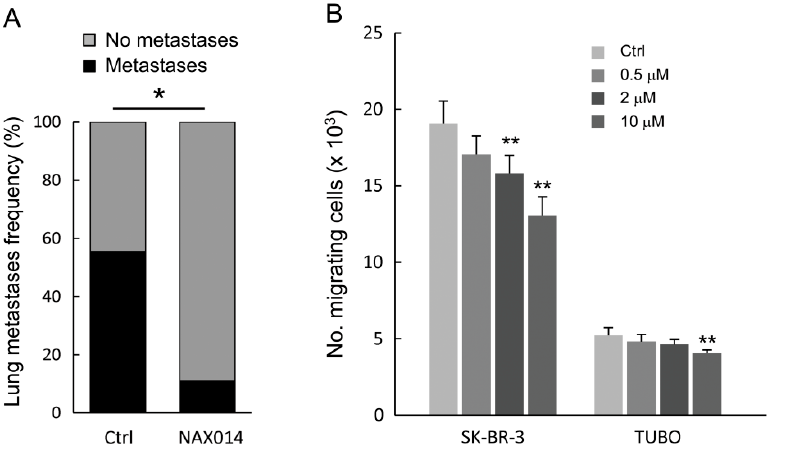
Figure 2. Effect of NAX014 on in vivo lung metastasis and in vitro cell migration. ( A ) Lungs from euthanized FVB/N HER-2/neu transgenic mice were excised and the presence of metastases was evaluated after staining by endotracheal infiltration with 15% china ink solution. Data are reported as percentage of mice with lung metastases for each group. * p ≤ 0.05 versus control group. ( B ) Human SK-BR-3 and murine TUBO cell lines were pre-treated with NAX014 (0.5, 2 and 10 µ M) for 48 h. The number of migrated cells was counted. Results of quantitative assessment are shown as the mean ± SD from four independent wells. Graph is representative of two independent experiments. ** p ≤ 0.05 vs. control cells treated with